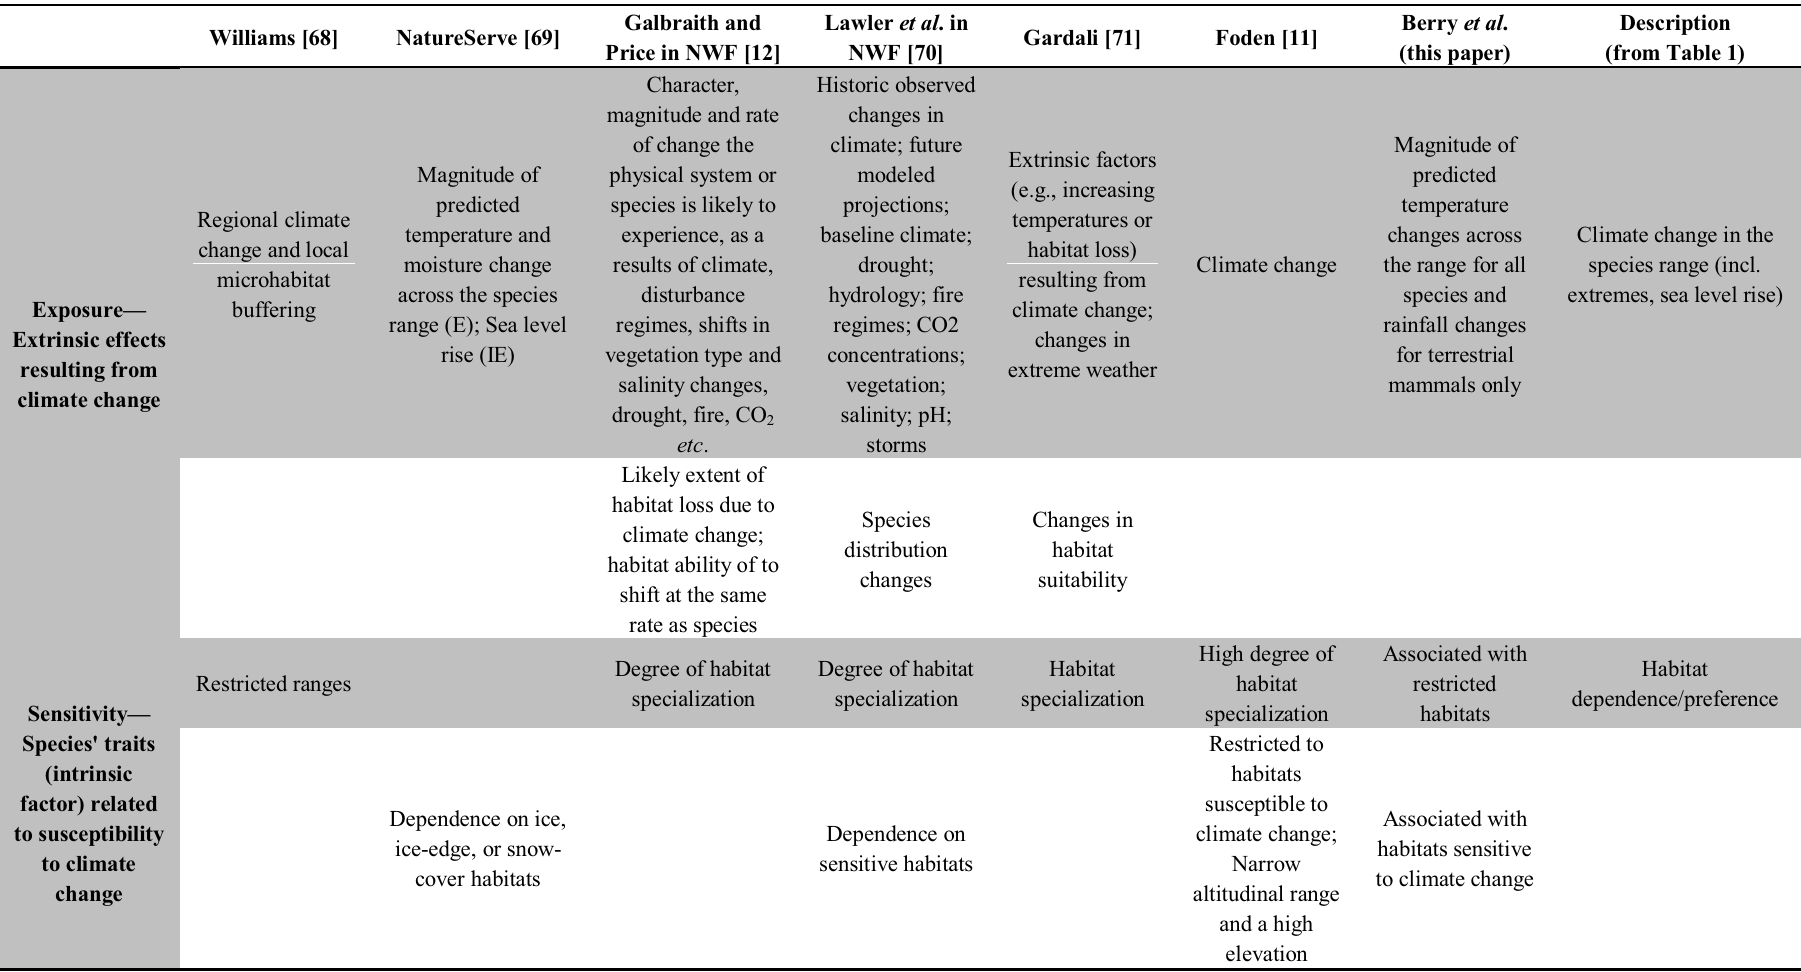
Table 7. A comparison of the components used in a selection of conservation-related vulnerability assessments and how they were classified. E = Exposure; S = Sensitivity; AC = Adaptive